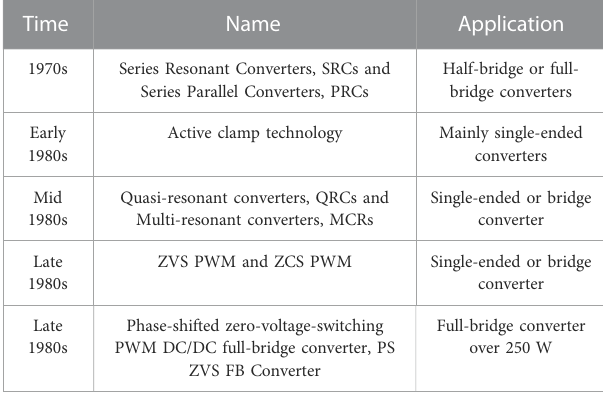
TABLE 1 Development history of soft-switching